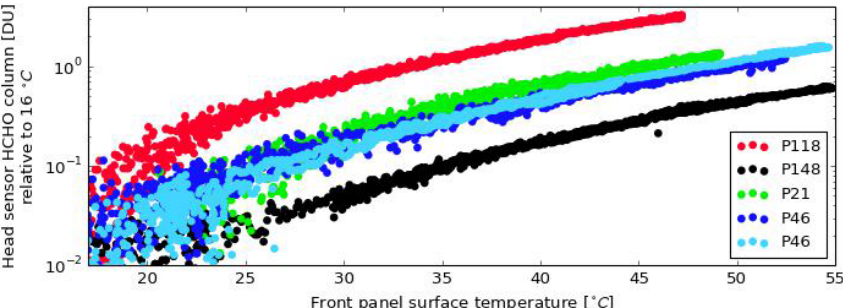
Figure 5. HCHO formation and deposition inside Pandora 118, 148, 21, and 46 as a function of front panel outside surface temperature relative to the individual head sensor measurements at 16 ◦ C. Pandora 46 was tested twice with a combination of temperature change rates (3 and 8.2 ◦ Ch − 1 in light blue and 3.5 ◦ Ch − 1 in dark blue).